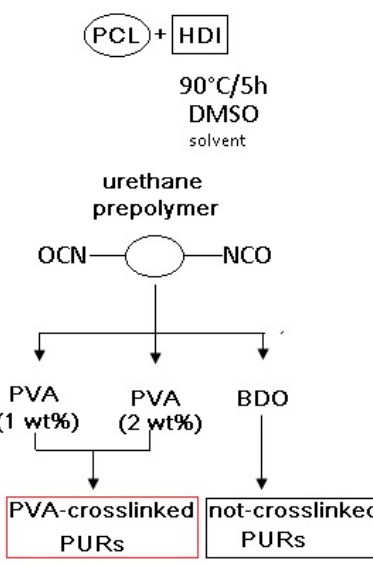
Figure 1 Scheme of PUR synthesis. Figure 1. Scheme of PUR